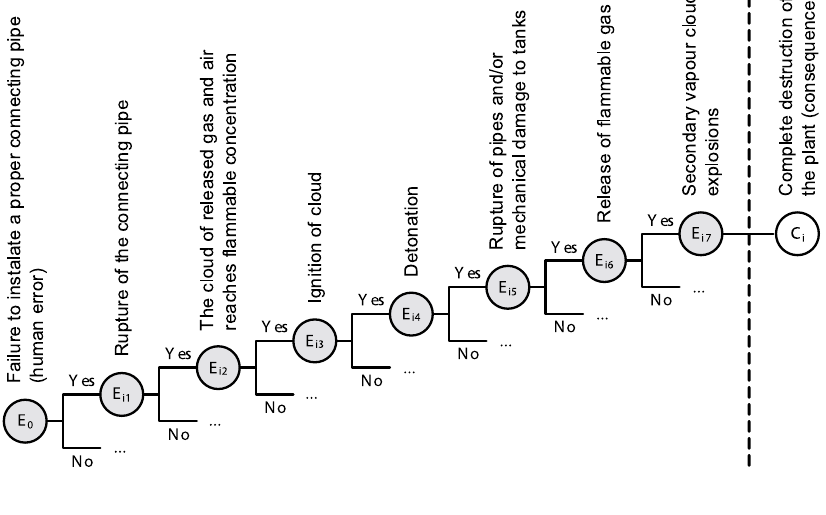
fig. 6. Event tree path that resulted in the complete destruction of the plant at Nypro factory,